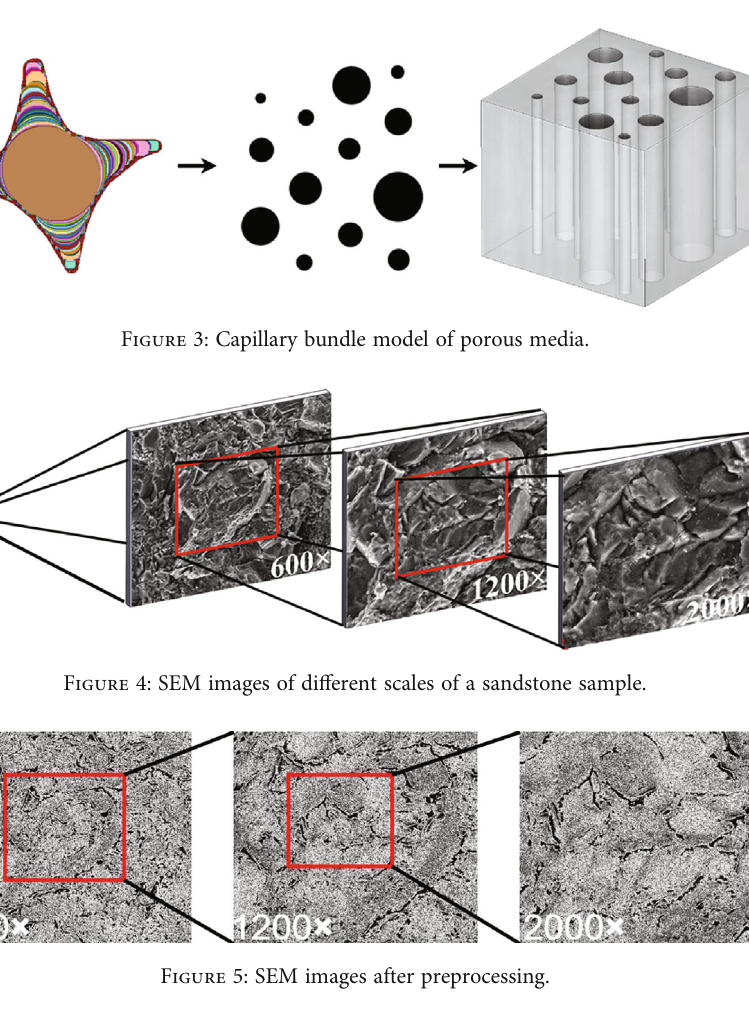
Figure 2: Comparison of calculation principles between DPSD and CPSD with the same pore structure.